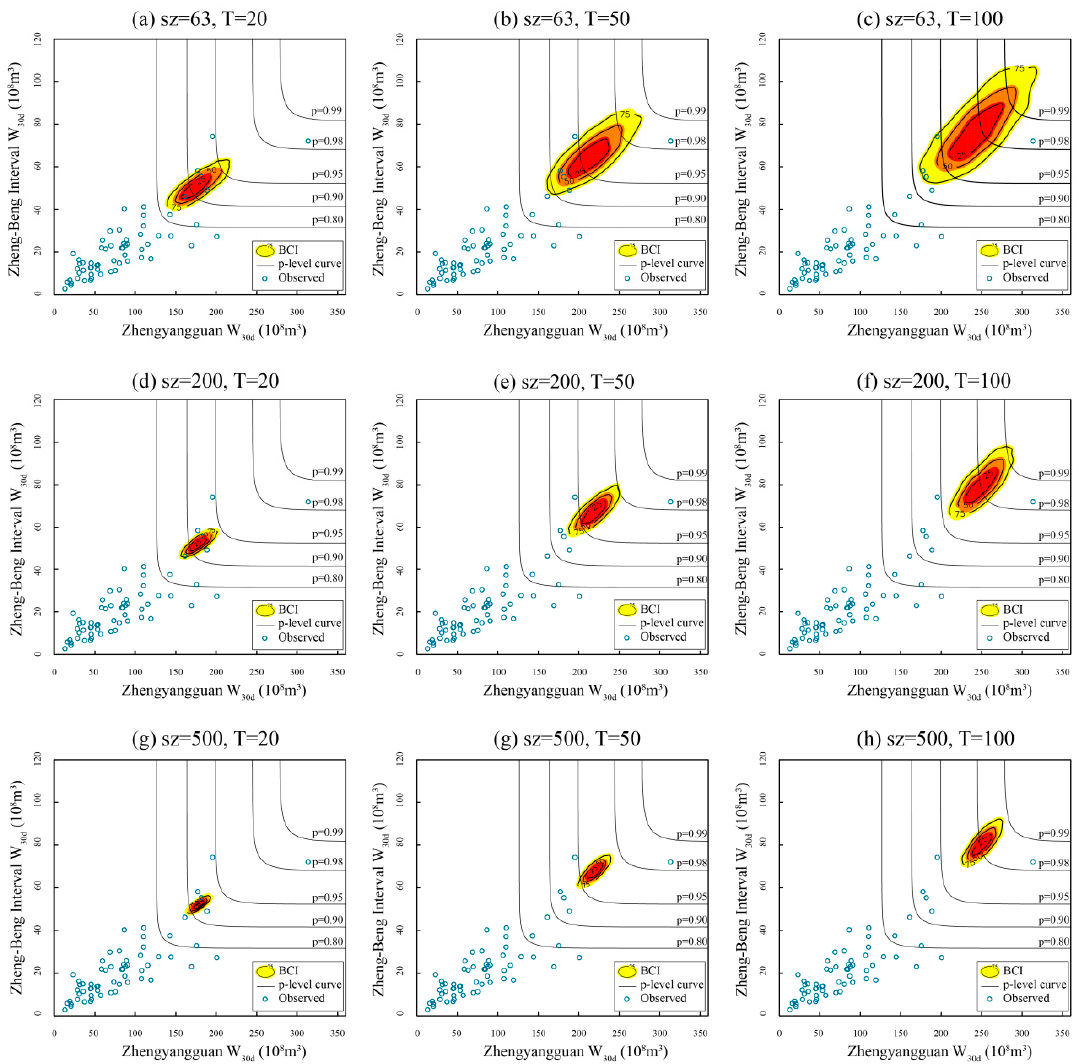
Figure 8. Comparison of CEC realizations under different schemes when the designed values occur in the Zheng-Beng interval.